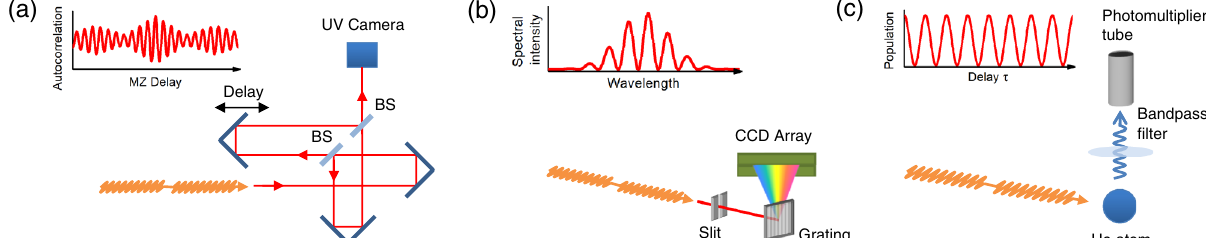
Figure 7. Experimental approaches used for characterizing the double-pulsed wave packet. ( a ) Autocorrelation measurement of the undulator radiation using a Mach–Zehnder interferometer in the UV regime. ( b ) Frequency-domain interferometry in the UV regime. The interference spectrum of radiation from the two undulators is recorded by a grating spectrometer. ( c ) Time-domain interferometry in the XUV regime. The fluorescence photons emitted from the 1s5p excited state of helium atom are detected by a photomultiplier tube equipped with a bandpass